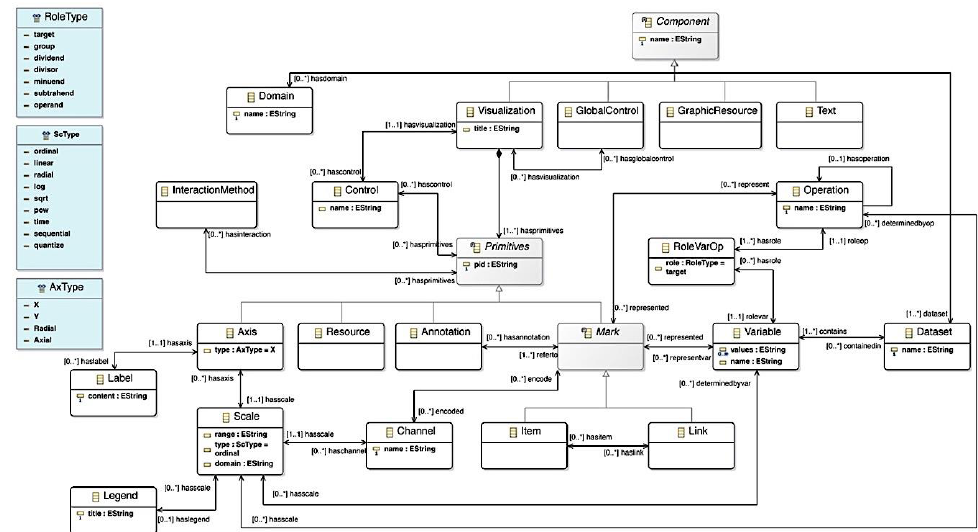
Figure 3. Detailed view of the dashboard meta-model components’ definition. This image is available in high resolution at https://doi.org/10.5281/zenodo.3561320. Licensed under CC BY 4.0.